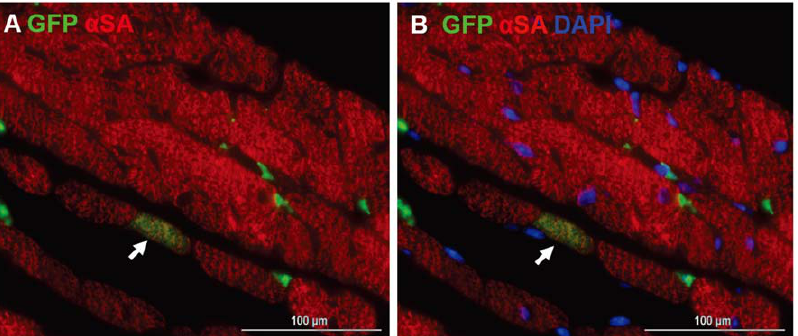
Figure 3. Myocyte transdifferentiation from GFP + bone marrow in adult heart 12 months after GFP + bone marrow transplantation. Co-staining of GFP and a -sarcomeric actin reveals a cardiomyocyte also positive for GFP, suggesting that GFP + bone marrow cells differentiate into cardiomyocyte in adult heart.